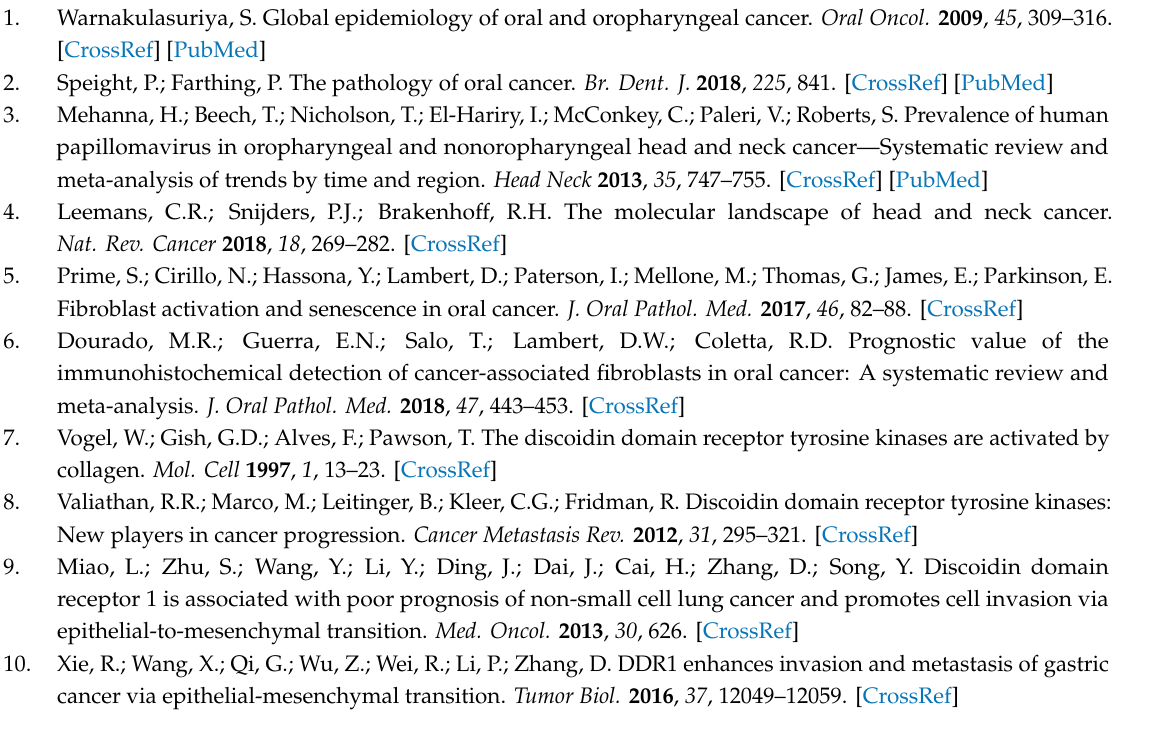
Figure S1: Expression of collagen in NHOFs and CAFs, Figure S2: Expression of COL8A1 and COL11A1 in OSCC, Figure S3: Figure 3A full blot, Figure S4: Expression of DDR1 in HNSCC cell lines and non-malignant keratinocytes, Figure S5: Expression of DDR1 in OSCC, Figure S6: E ff ect of DDR1 knockdown on cell proliferation, migration and response to cisplatin, Figure S7: Validation of the specificity of the antibody against DDR1, Table S1: Association between DDR1 and COL8A1 protein expression with OPSCC risk of death groups, Table S2: Overexpression of DDR1 in HNSCC, Table S3: Socio-demographic and clinico-pathological characteristics of OPSCC cases, and Table S4: Socio-demographic and clinico-pathological characteristics of OSCC